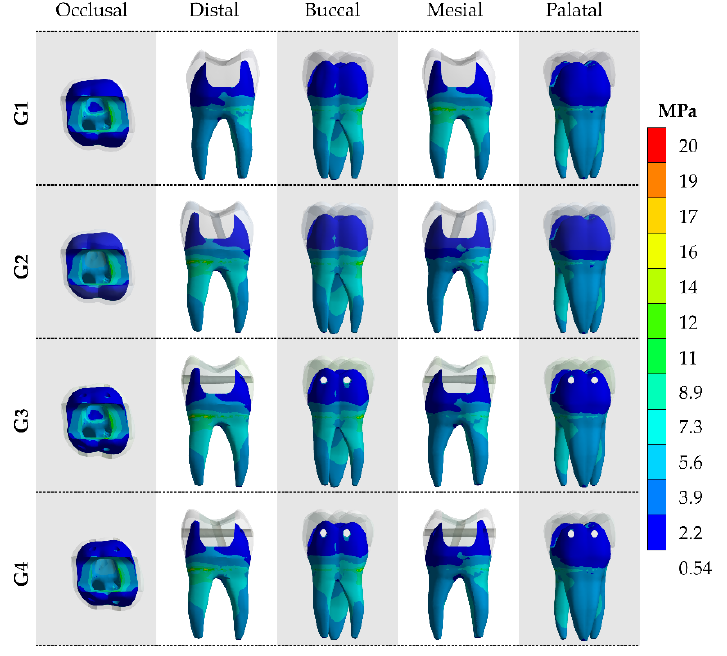
Figure 6. The von-Mises stress (MPa) concentration from five different viewpoints in the enamel tissue according to the GFP treatment.